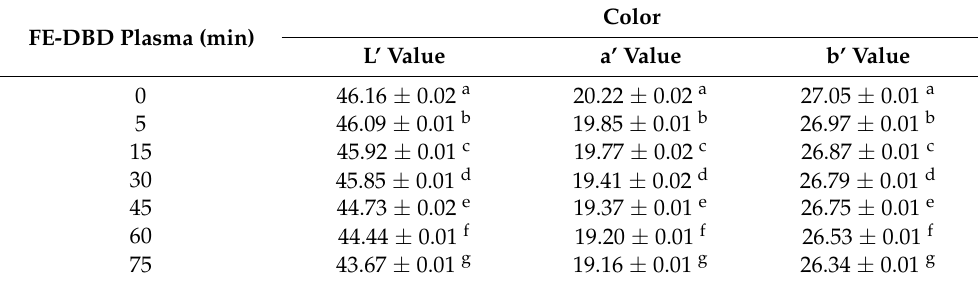
Table 6. Hunter color of sea squirt by FE-DBD plasma treatment.